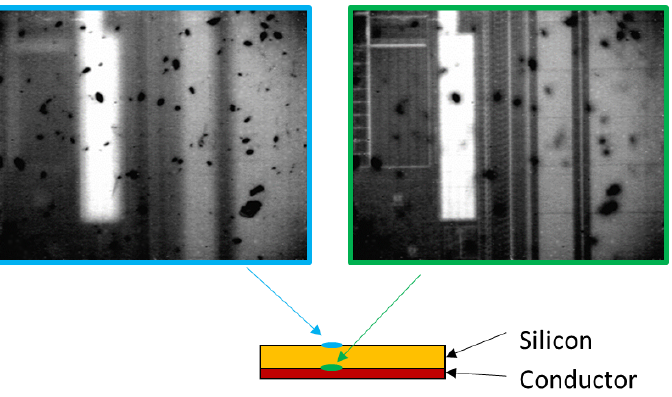
Figure 2. View of contaminants on the silicon surface (blue), shadowing the conductive tracks (green). Today, the targeting process that precedes characterization is carried out